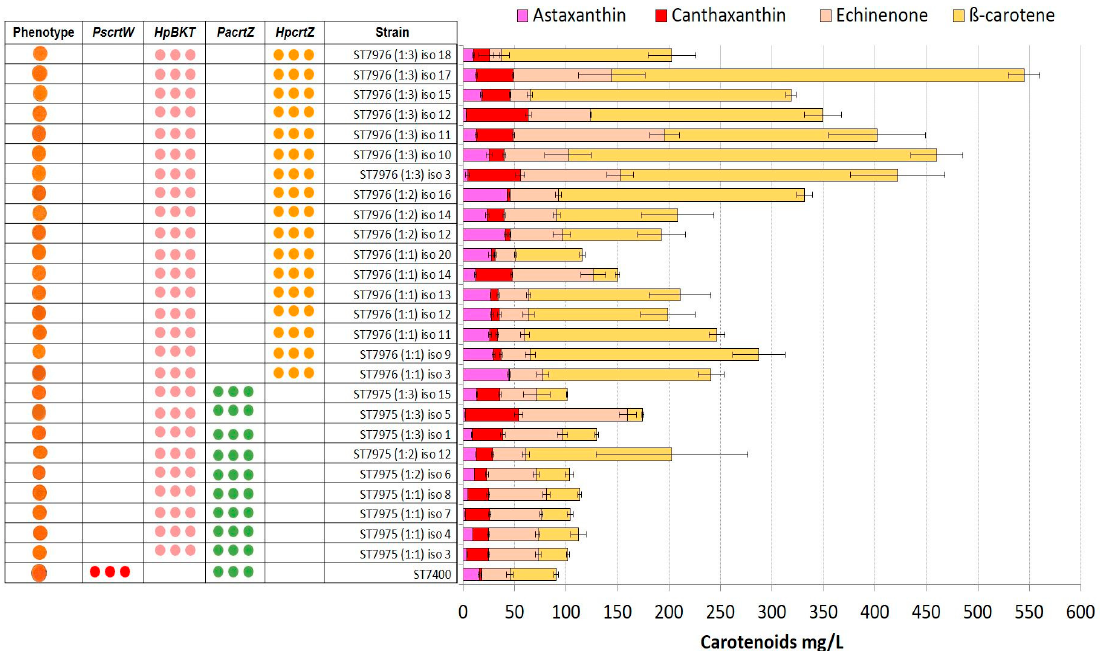
Figure 6. Carotenoid production by strains ST7975 and ST7976 transformed with combinations of HpBKT and PacrtZ / HpcrtZ genes. Molar ratios of DNA constructs are in brackets. Strain used as positive control: ST7400. Three dots represent multiple integrations of genes. All strains were cultivated in YP + 8% glucose in 24-deep-well plates for 72 h. The error bars represent standard deviations calculated from triplicate experiments (“iso” after each strain indicates the isolate number).